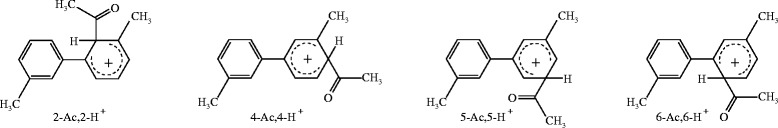
The σ-complexes for monoacetylation.